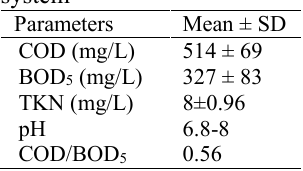
Table 1. The characteristics of Kermanshah's